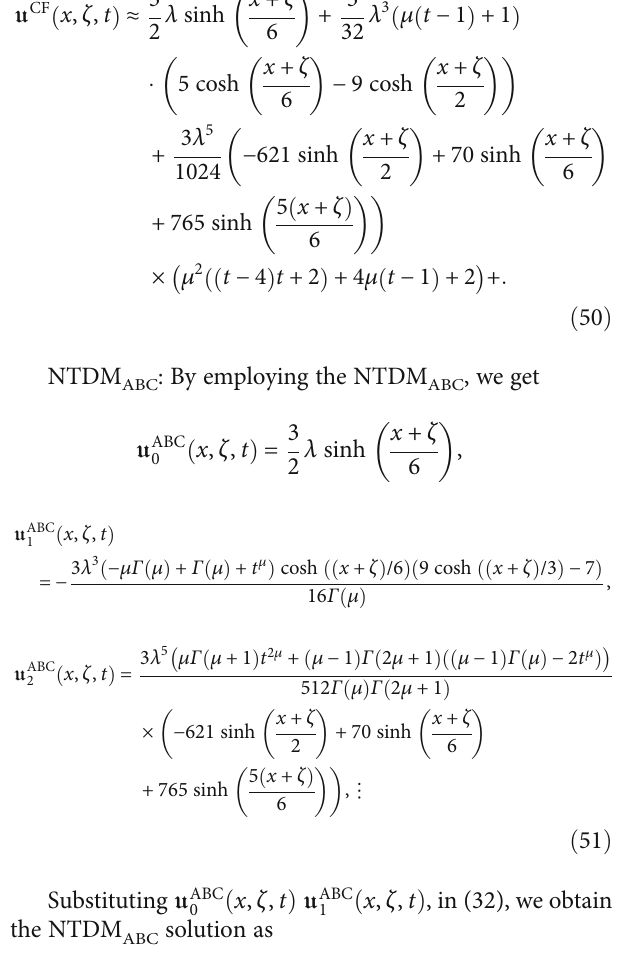
Table 4. For Example 2, NTDM and NTDM absolute CF ABC errors graphically represent in Figure 4 for fi xed t when μ = 1 , and in Figure 5, we plotted approximate solutions for di ff erent values of μ for speci fi c value of t . Figure 6 presents the comparison of NTDM and NTDM with exact solu- CF ABC tion for noninteger values of μ for fi xed t and ζ of Example